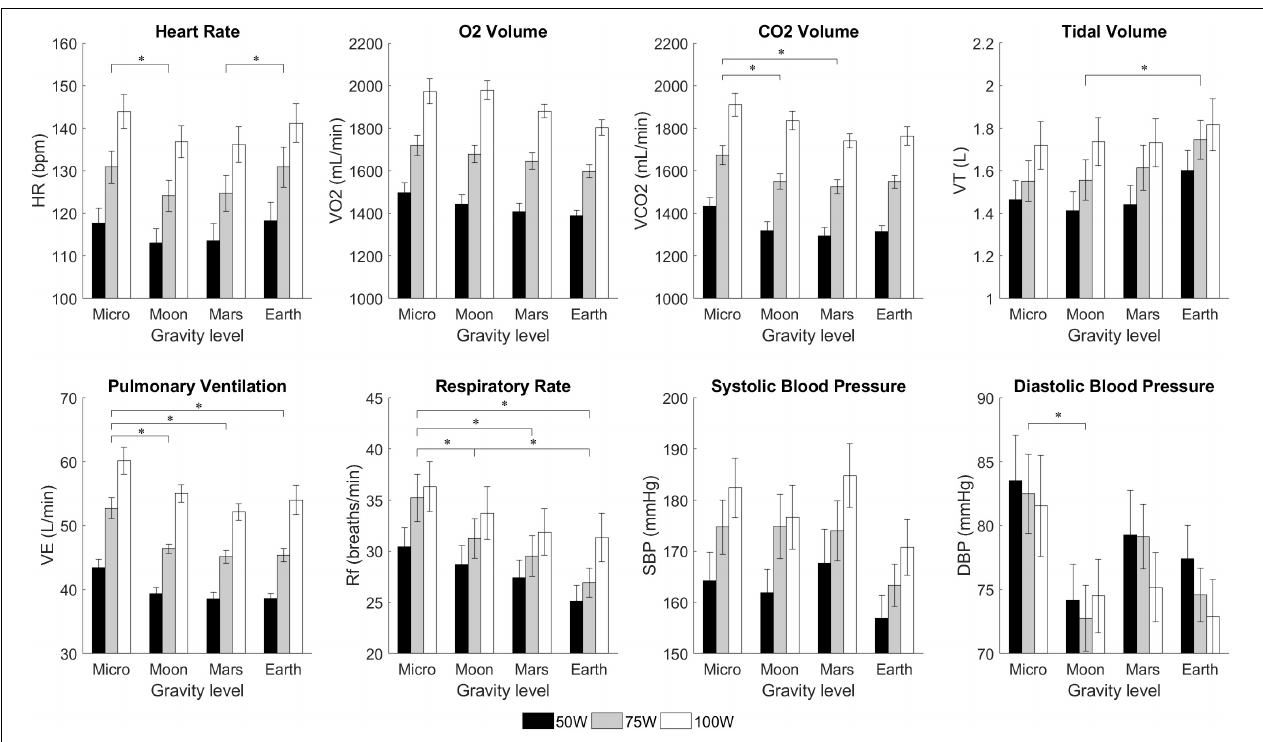
FIGURE 5 | Cardiopulmonary variables from 14 subjects (mean ± SE) at different workload intensities for each of the altered-gravity environments (Microgravity − 6 ◦ HDT, Moon + 9.5 ◦ HUT, Mars + 22.3 ◦ HUT, Earth + 90 ◦ upright). The figure highlights significant differences between altered-gravity levels (pairwise comparisons after a 2-factor repeated measures ANOVA with Bonferroni correction, ∗ significantly different at p < 0.05). Statistical differences between workload intensities, including all possible pairwise comparisons, were also found in all variables except diastolic blood pressure. For clarity, these differences are not shown in the figure.